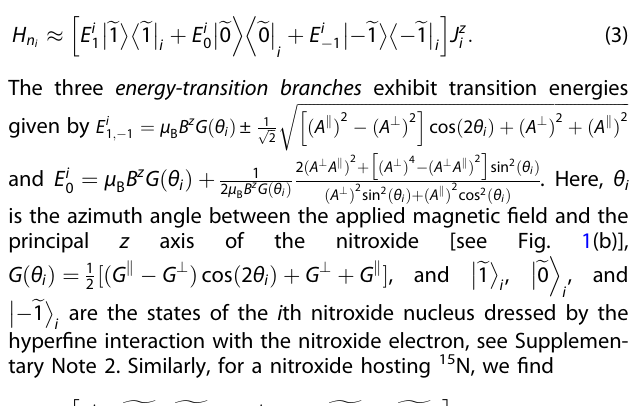
pares the energy-transition branches in Eqs. (3) and (4) (dashed lines) with numerical diagonalization of Eq. (2) (solid lines). Note